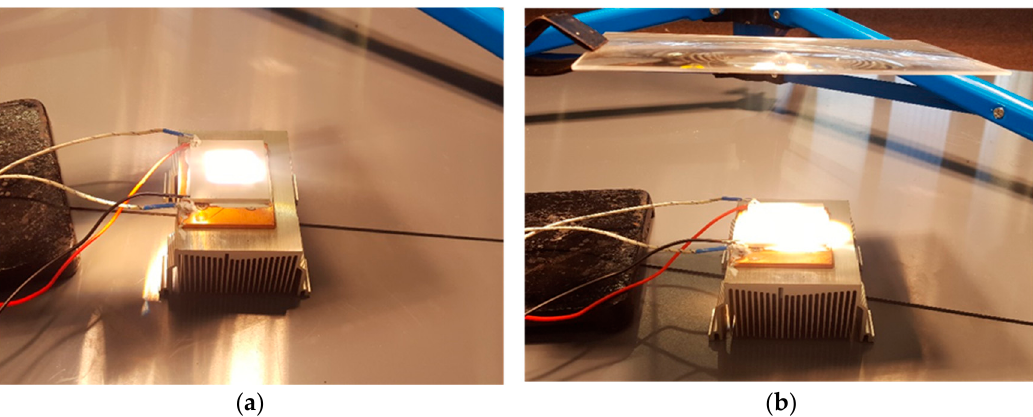
Figure 16. ( a ) Quartz-halogen concentrated light and heat on to the surface area of TEG covering ( a ) centre ( b ) whole of the module.